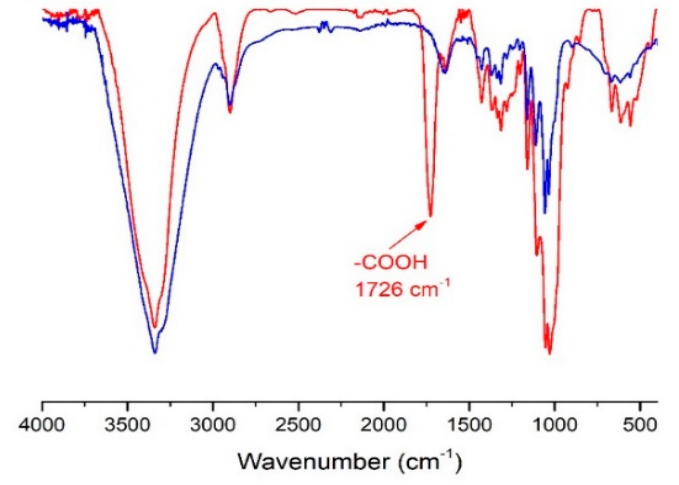
Figure 5. FT-IR spectra of nanocellulose fibres (CNF(W)) - blue line; and nanocellulose fibres func- tionalized with carboxyl groups (CNF-COOH) - red line.